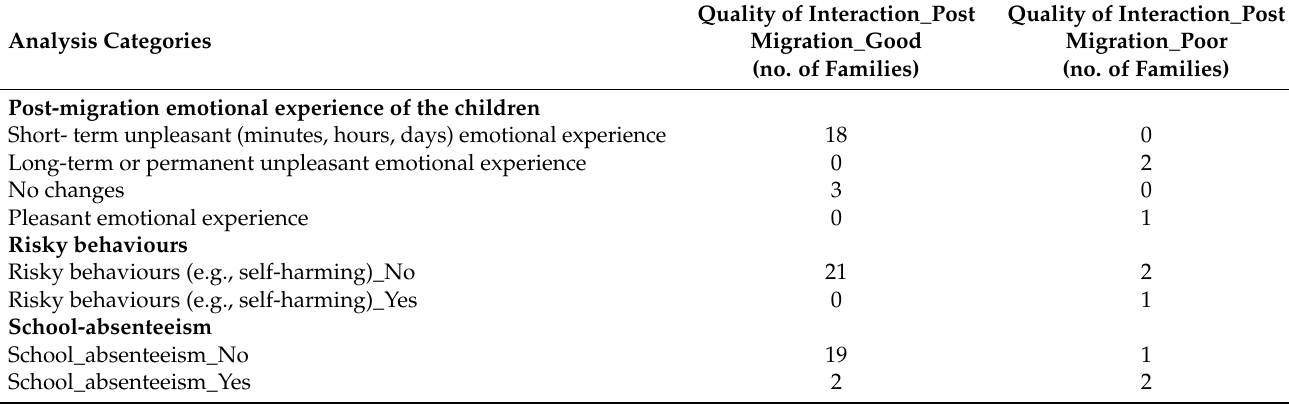
Table 5. The effects of poor quality of interaction with the migrating parent(s) on children